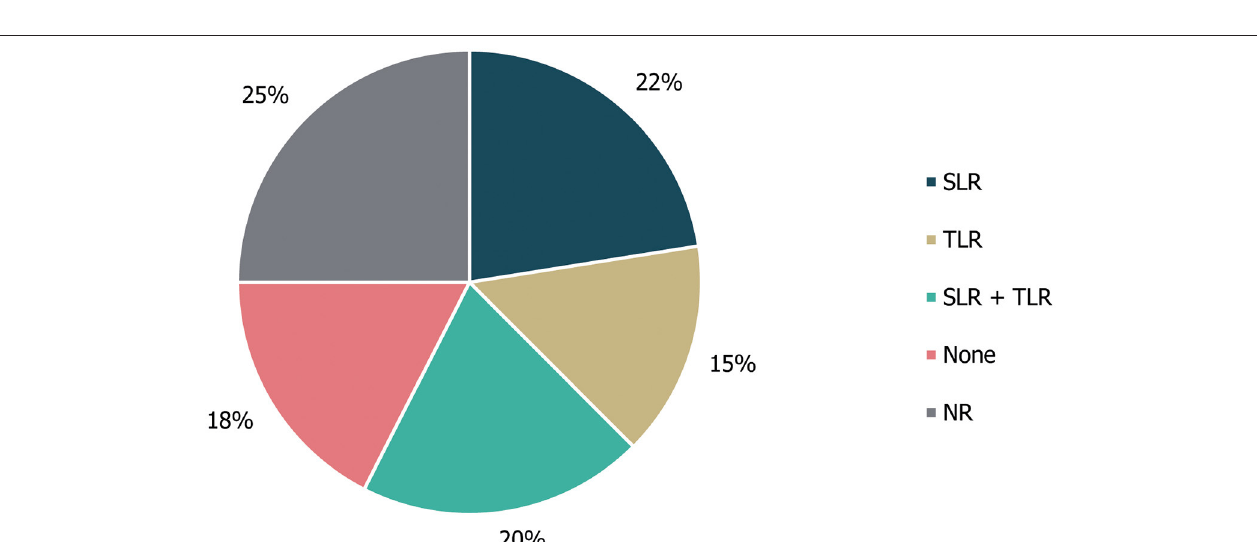
FIGURE 2 | Geographies of identified guidelines. *No guidelines were identified for use in Israel or Switzerland. The geography of guideline use refers to the country for which that the guidance was specifically developed.